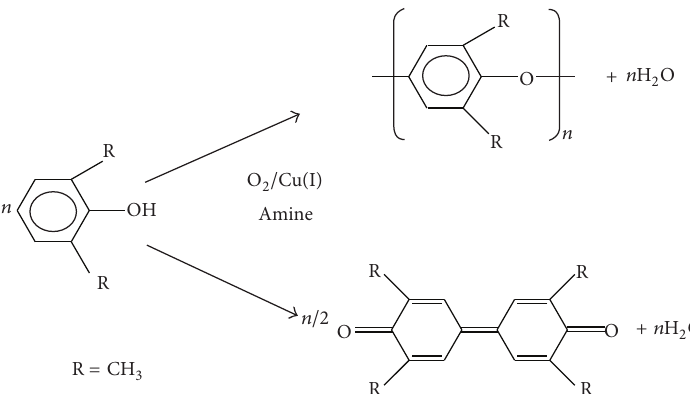
S 1: Polymerization reaction of 2,6-phenylphenol by oxidation using the CuCl in amine.